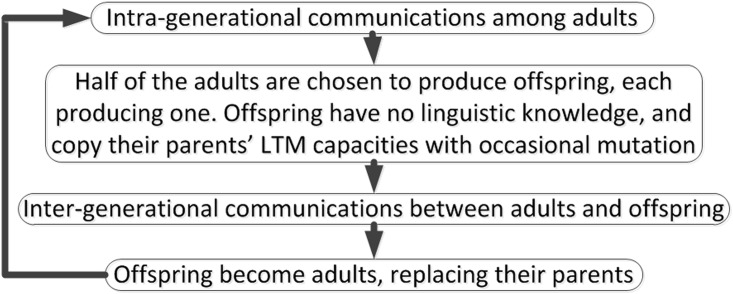
Theoretical framework (adapted from [41]).